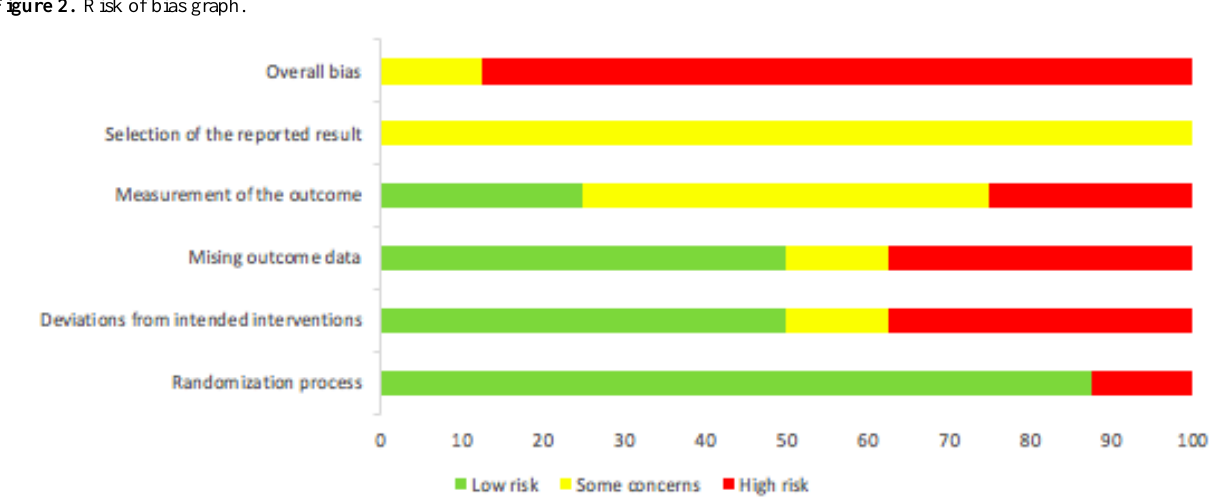
Figure 2. Risk of bias